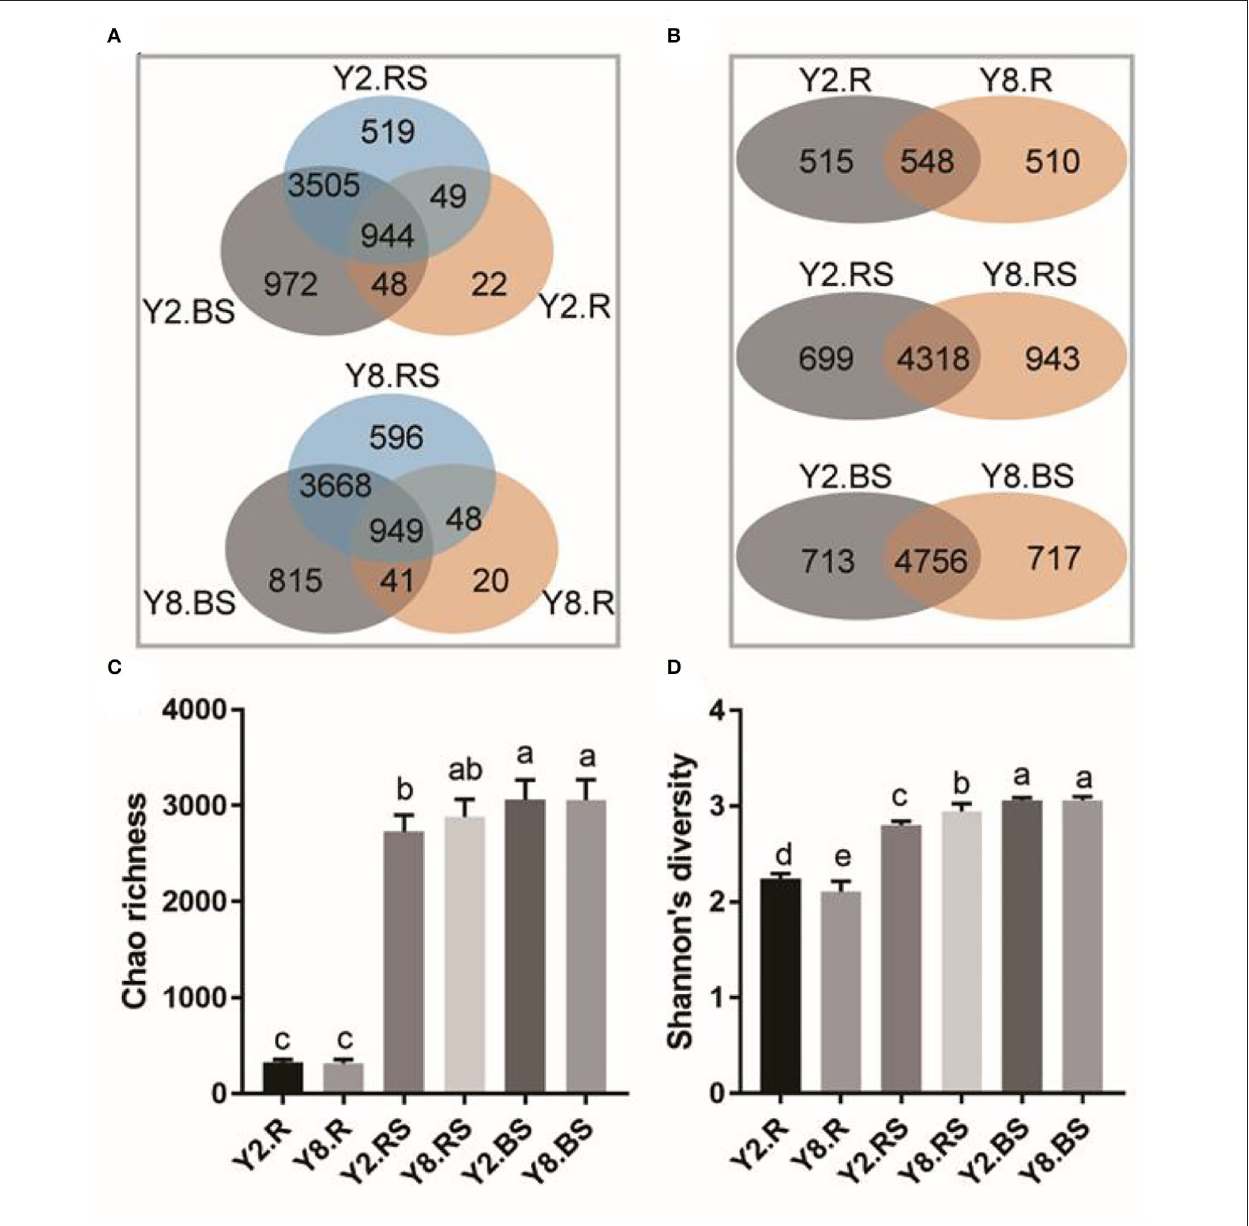
FIGURE 3 | The distribution of operational taxonomic units (OTUs) and the bacterial community richness and diversity among different comparison groups. (A) Venn diagram of different parts of Y2 and Y8. (B) Venn diagram of R, RS, and BS between Y2 and Y8. (C) Chao richness. (D) Shannon’s diversity. Y2.R, root of 2 years of continuous cropping; Y8.R, root of 8 years of continuous cropping; Y2.RS, rhizosphere soil of 2 years of continuous cropping; Y8.RS, rhizosphere soil of 8 years of continuous cropping; Y2.BS, bulk soil of 2 years of continuous cropping; Y8.BS, bulk soil of 8 years of continuous cropping. The different lowercase letters indicate significant differences between different treatments ( p <